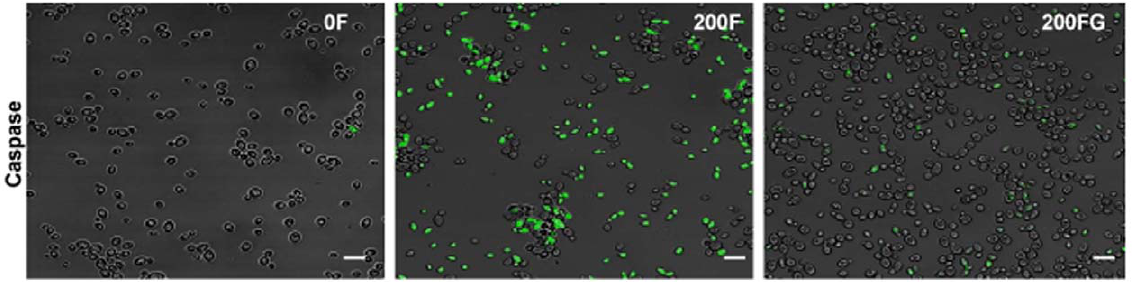
Figure 6. Representative confocal scanning laser fluorescent images of C.albicans cells stained for intracellular caspase activation following treatment with 200 m M farnesol in the absence (F) and presence (FG) of exogenous glutathione. Significant activation of intracellular caspases in farnesol-exposed cells as indicated by green fluorescence with minimal fluorescence in cells treated with glutathione. Bar represents 20 m m.